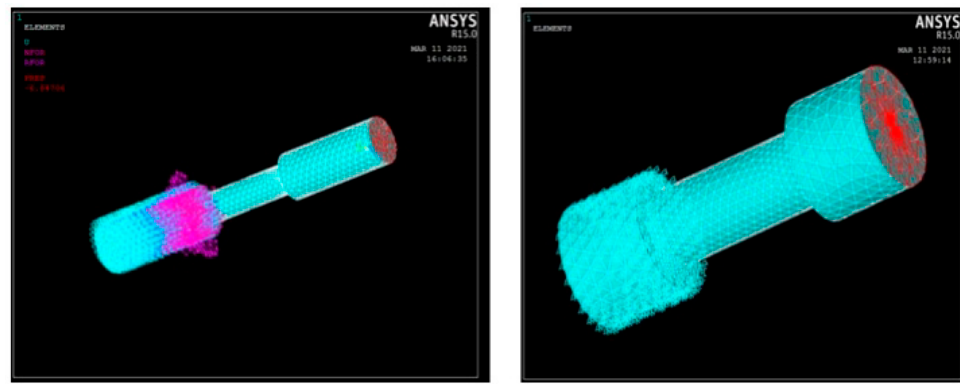
Figure 13. Convergence mesh generation on IGES format specimen model. Table 15. Mechanical testing outcomes of tensile and compressive pressures.